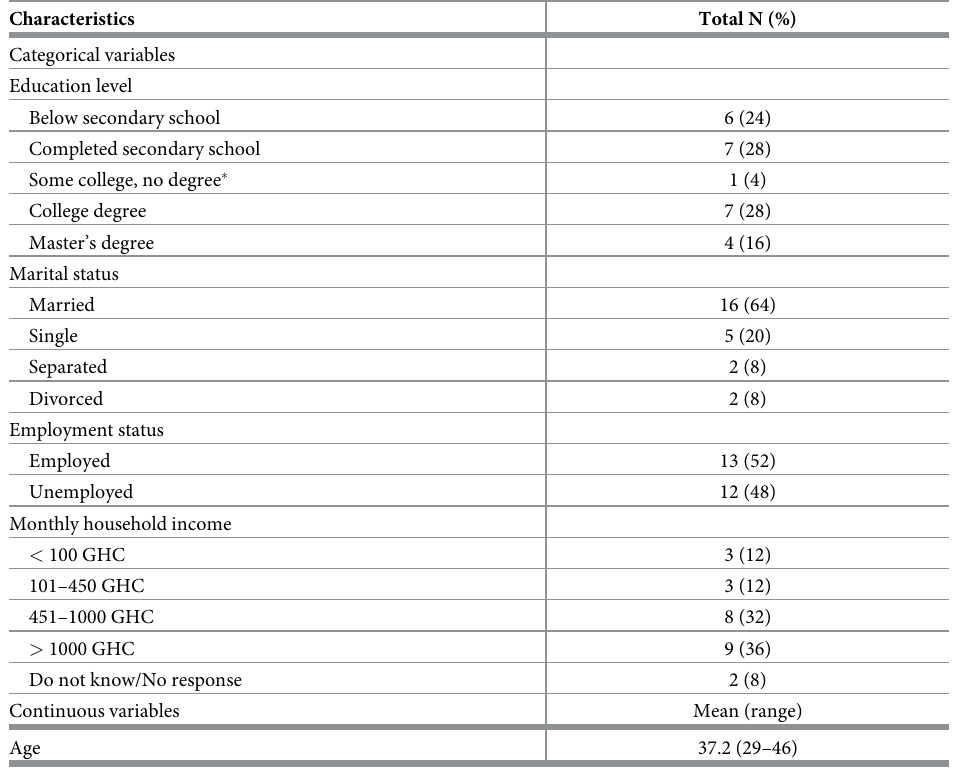
Table 2. Background characteristics of caregivers, N =